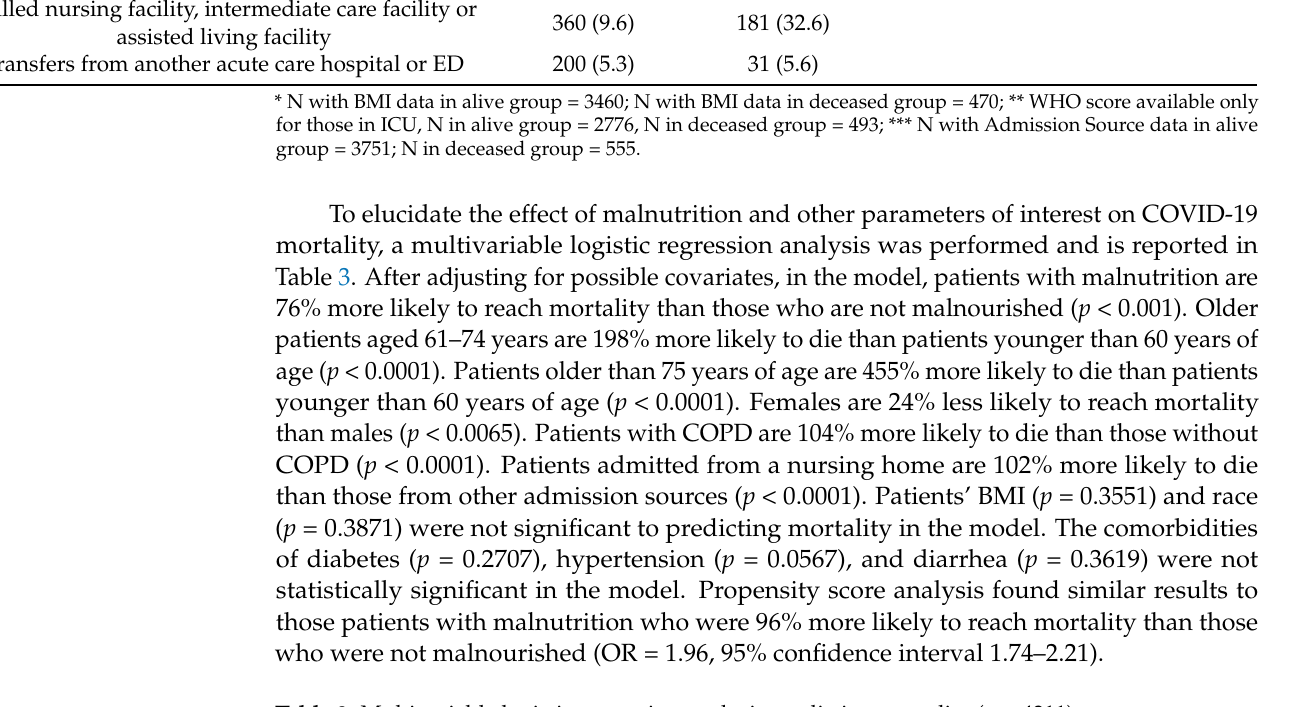
Table 3. Multivariable logistic regression analysis predicting mortality (n =